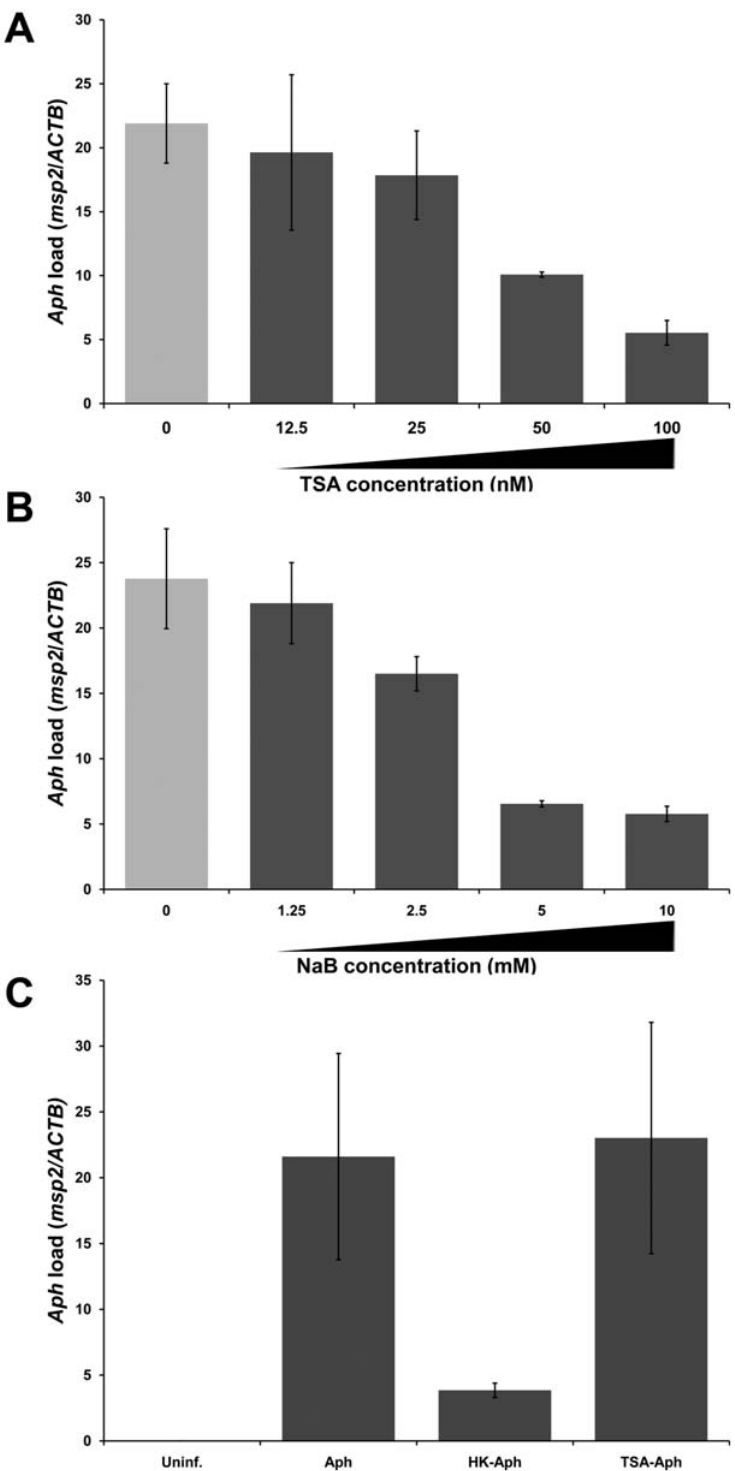
Figure 4. HDAC inhibition impairs the ability of A.phagocytophilum to propagate intracellularly. THP-1 cells were infected with cell-free A. phagocytophilum and incubated with or without the HDAC inhibitors TSA and sodium butyrate. Twenty-four hours post infection, cells were collected and A. phagocytophilum infection level was determined by qPCR. The first point represents infection level in the absence of HDAC inhibitor. Cells were incubated with (A) TSA or (B) sodium butyrate. Infection levels were normalized for b -actin gene content to account for differences in the number of viable cells. (C) Cell-free A. phagocytophilum preincubated with 100 nM TSA for 2 hours prior to infection was used to infect THP-1 cells as described. A. phagocytophilum load was determined by qPCR 24 hours later.